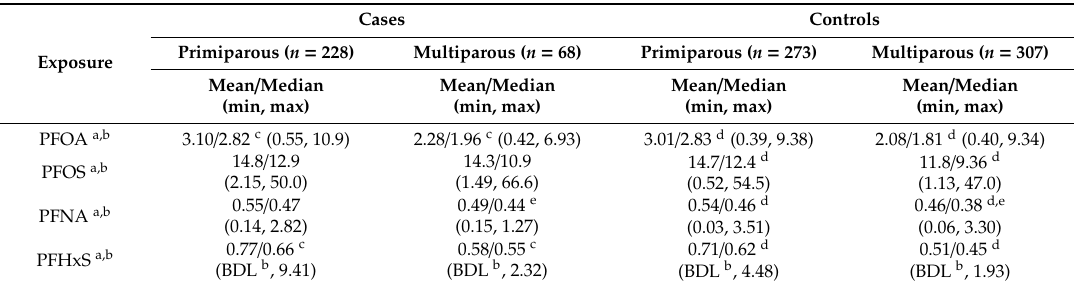
Table 3. Serum concentrations of the di ff erent PFAS compounds (ng / mL) in early pregnancy among 296 preeclampsia cases and 580 controls divided by parity. For comparisons, only statistically significant ( p < 0.05) are marked.